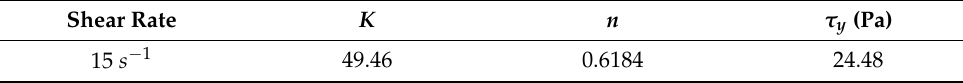
Table 2. Rheological parameters of the conductive paste. Shear Rate